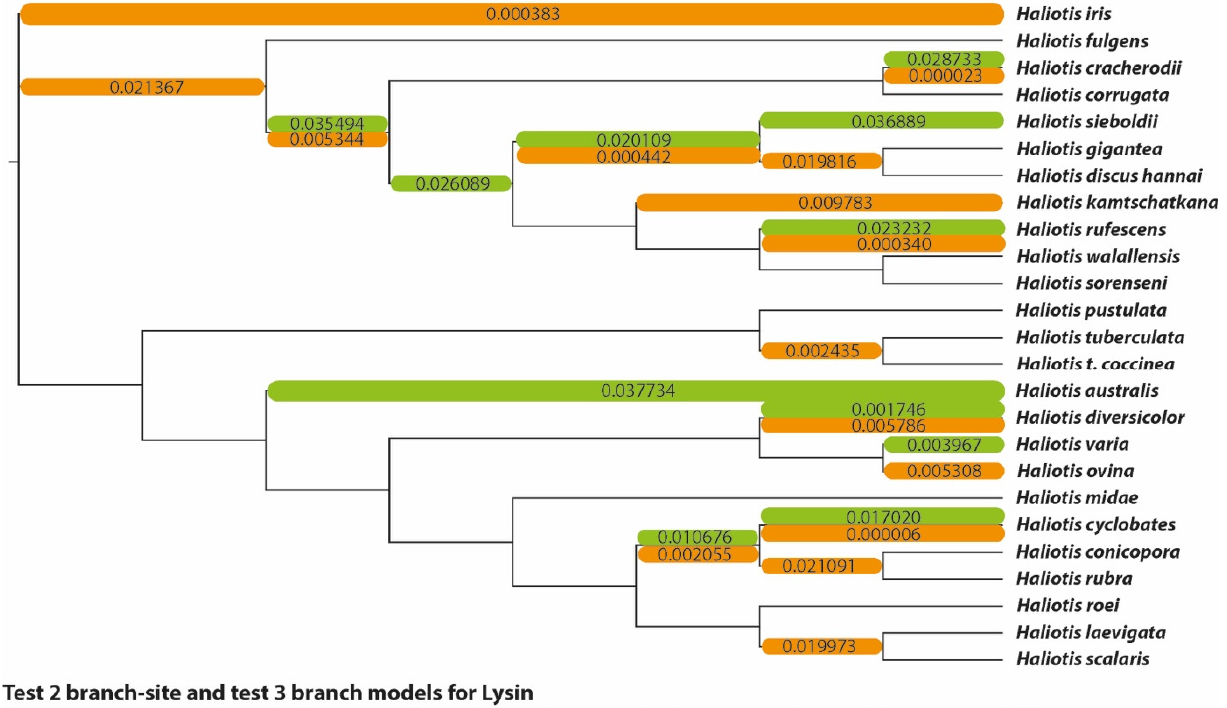
Figure 6. Phylogenetic tree of the lysin dataset. Branches significantly likely to be under positive selection according to the branch-site and branch models are marked orange and green, respectively (corresponding to Figure 2) and labelled with the p -values inferred by their respective model compar- isons. This includes branches with significant LRT results in the branch-site model but without sites under positive